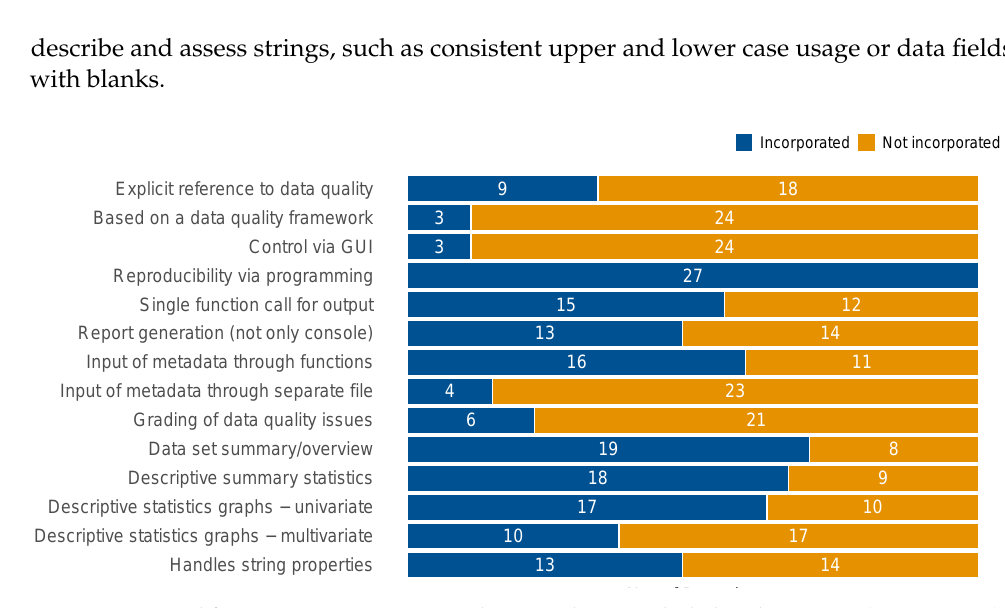
Figure 4. General feature comparison across the 27 packages included in this review (Section